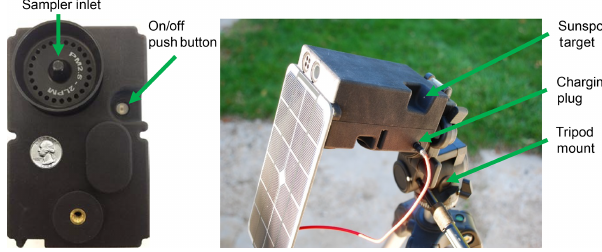
Figure 2. Photographs highlighting AMOD external